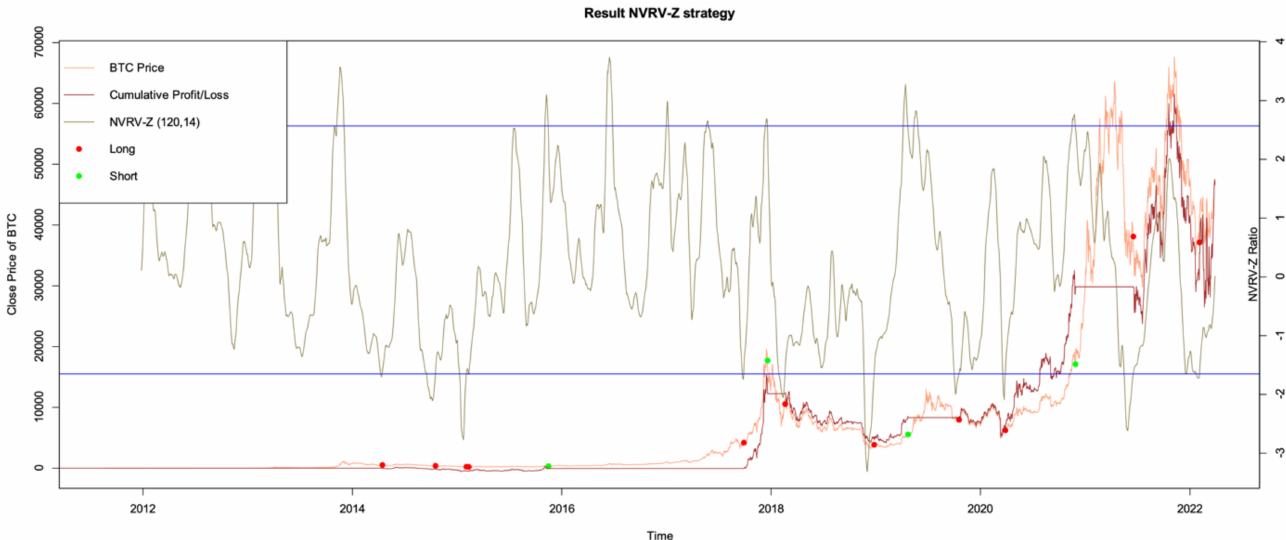
Figure A2. NVRV-Z strategy: BTC price (orange line, left-hand side), cumulative profit/loss (red line, left-hand side), NVRV -Z ratio (brown line, right-hand side), long and short thresholds (blue lines, right-hand side), long orders (red points) and short orders (green